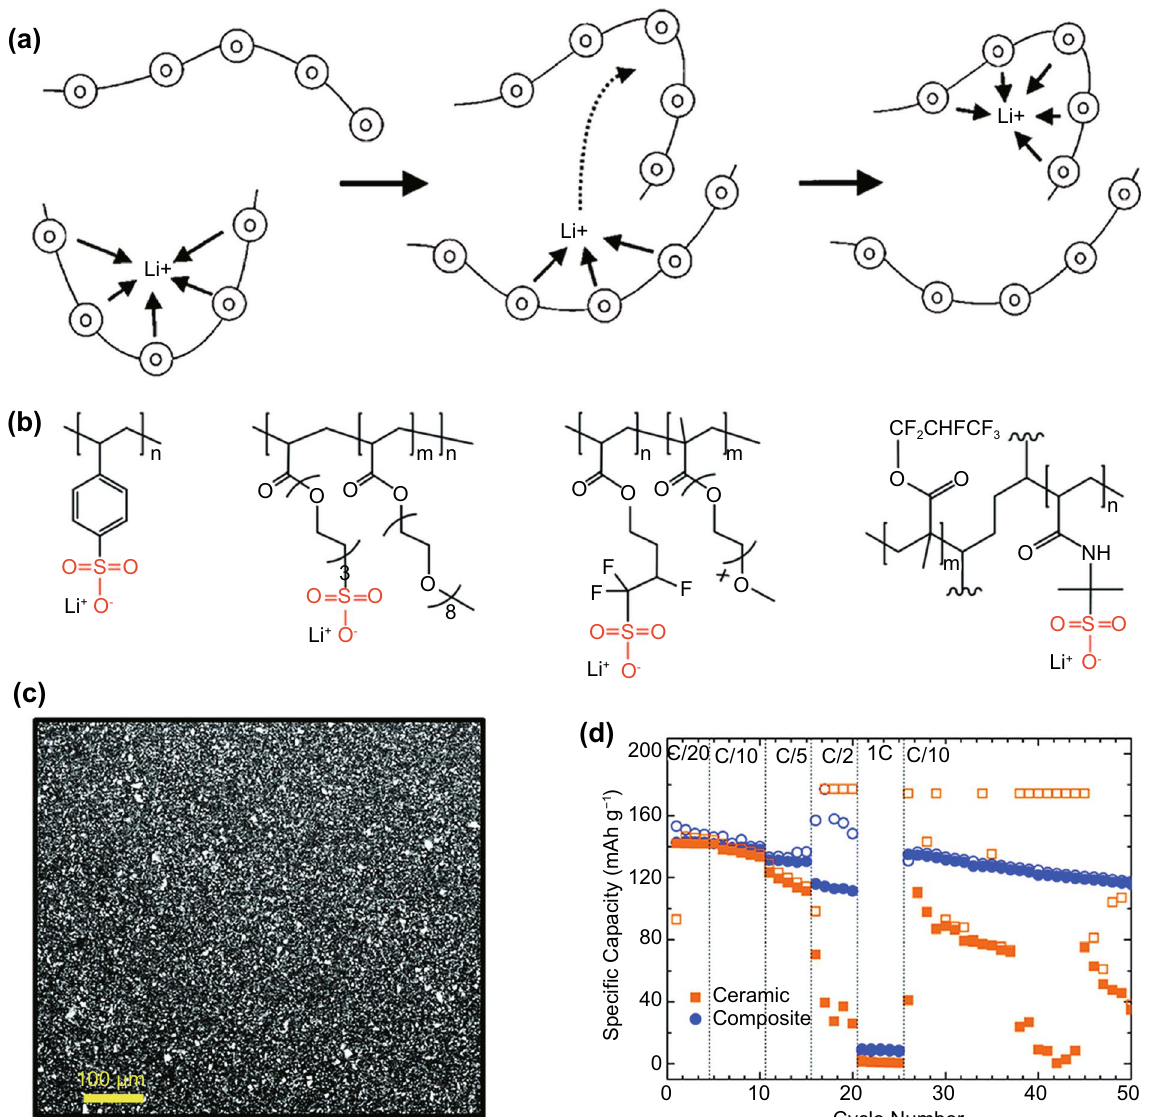
Fig. 17 a Illustration of the ion conduction mechanism for dilute polymer solid electrolytes [241] . Copyright 2016, Elsevier. b Schematic of selected sulphonate-based polymer electrolytes. Notice the various side group modifications that affect the charge density of the sulphonate group, thus affecting the coordination strength with the lithium ion [243] . Copyright 2018, Royal Society of Chemistry. c Scanning electron micrograph of a polymer–ceramic composite electrolyte, with its d rate performance exceeding a pure ceramic electrolyte despite having a lower ionic conductivity, due to its ability to be processed into a thinner membrane. Open and filled symbols represent charge and discharge capacities, respectively [238] . Copyright 2018, Royal Society of